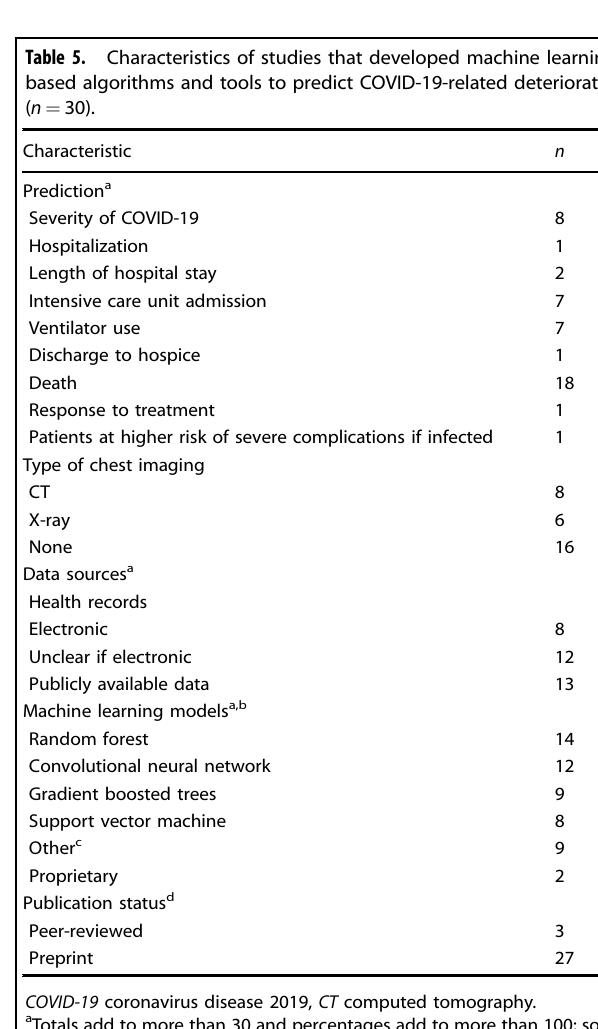
Fig. 4 Example of a ML solution for detecting and estimating the extent of COVID-19 infection based on CT images. The image on the left shows a patient infected with COVID-19. The image on the right shows a patient negative for COVID-19. Images courtesy of RADLogics, Inc., used with permission.